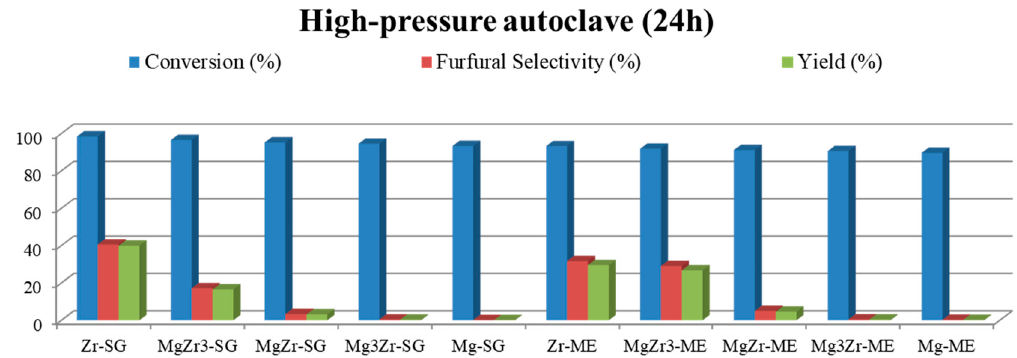
Figure 8. Catalytic activity for both series of catalysts in xylose dehydration in a high-pressure autoclave in a toluene/water biphasic media at 150 °C. Xylose conversion and furfural selectivity and yield.